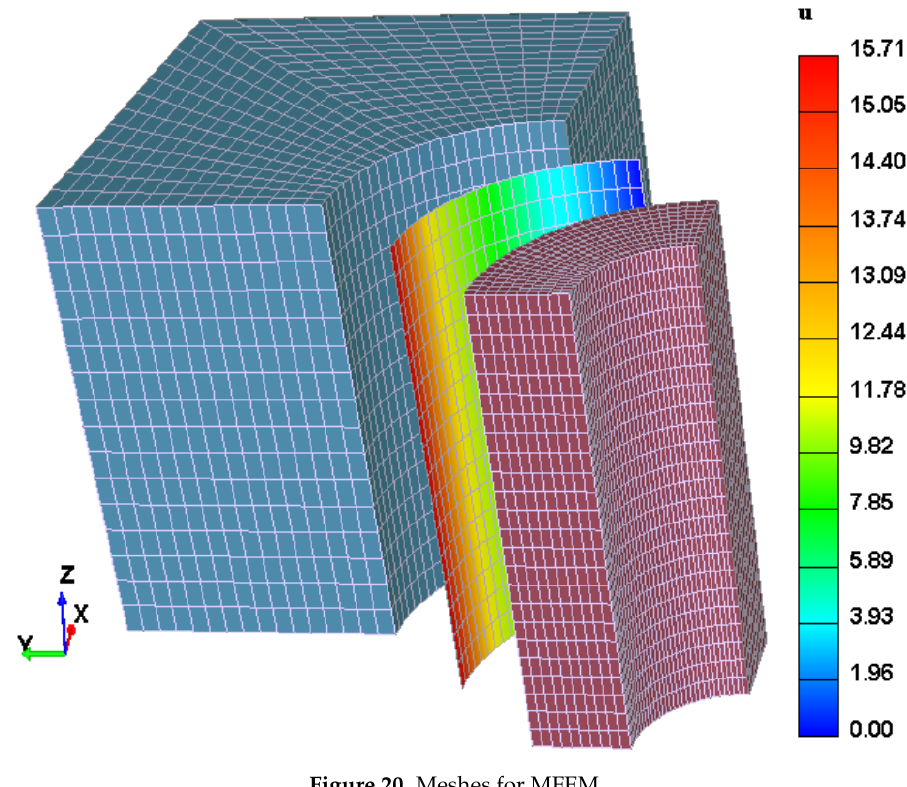
Figure 20. Meshes for MFEM. Table 6. Meshes employed with